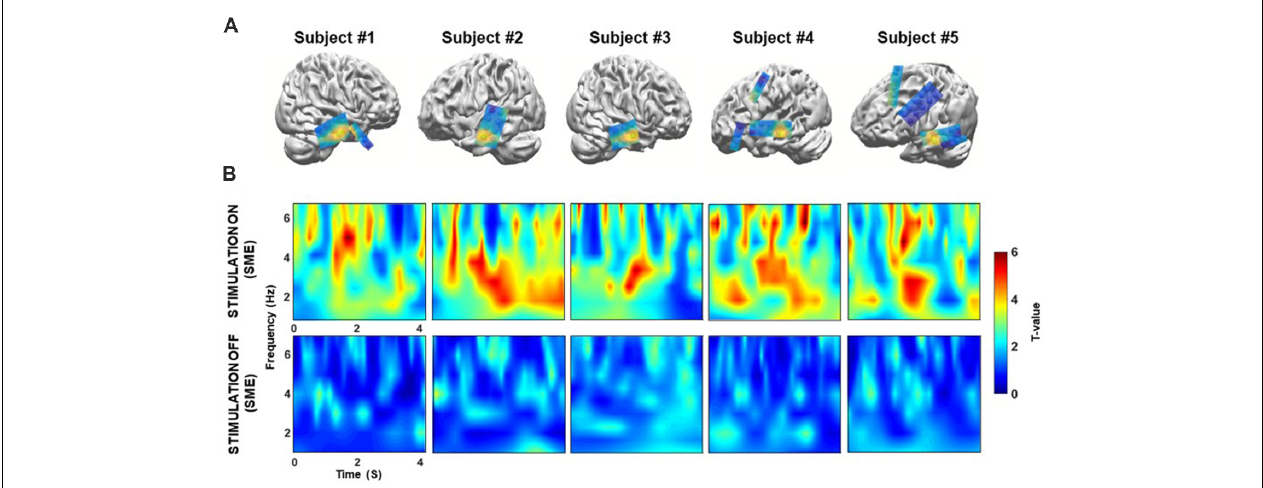
FIGURE 5 | (A) Location of the target in the lateral temporal cortex in the sagittal plane following co-registration of preoperative high-resolution MRI and postoperative CT images (not illustrated), for patients 1–5, respectively. Spheres indicate the location of the recording site. Topographical maps of differences in theta power between the correct and incorrect responses during both the “on” and “off” condition. The yellow sphere denotes locations in which significant increases in theta power were observed in the “on” condition that were higher than those observed in the “off” condition. The yellow sphere indicates the region for the time-frequency map in panel B. Some electrode grids/strips were excluded because they were not visible. (B) Time-frequency map comparing correctly and incorrectly remembered pairs during the “on” and “off” period for five patients. On the x-axis, 0 s indicates the onset of the memory task. During the “on” condition, theta (3–7 Hz) power was significantly increased during the 4 s of word presentation ( p < 0.05, corrected) for successfully recognized trials. In contrast, no significant increases in theta power were observed during the “off” condition ( p > 0.05,